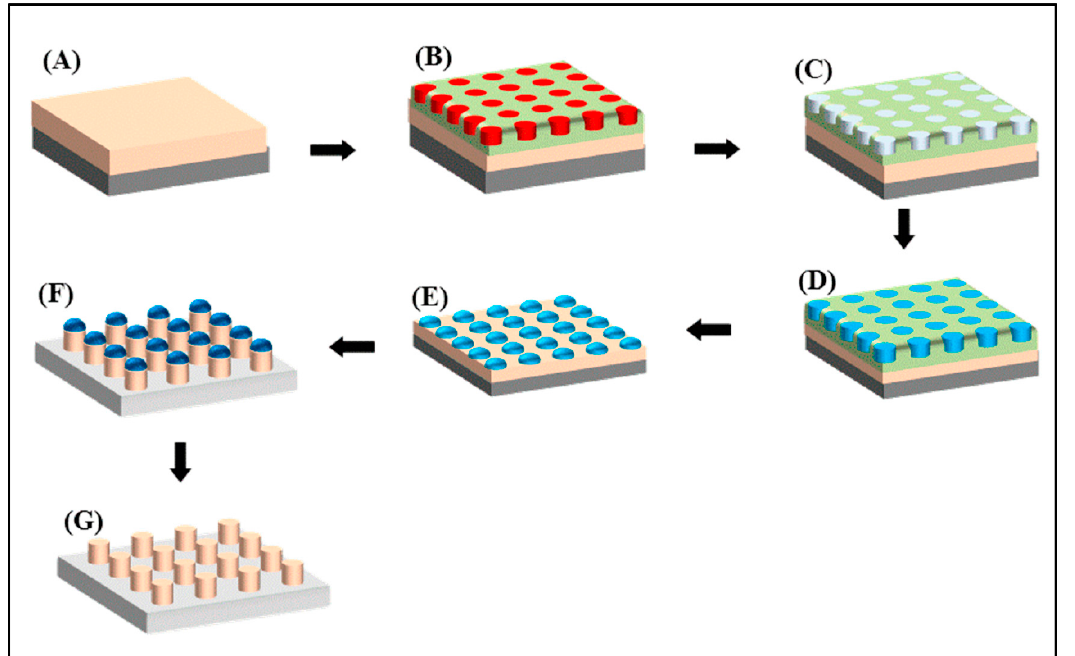
Scheme 4. Schematic illustration of the fabrication mesoporous silica channels using in situ hard mask BCP approach. ( A ) MPS thin film on Si substrate ( B ) Hexagonally arranged PEO